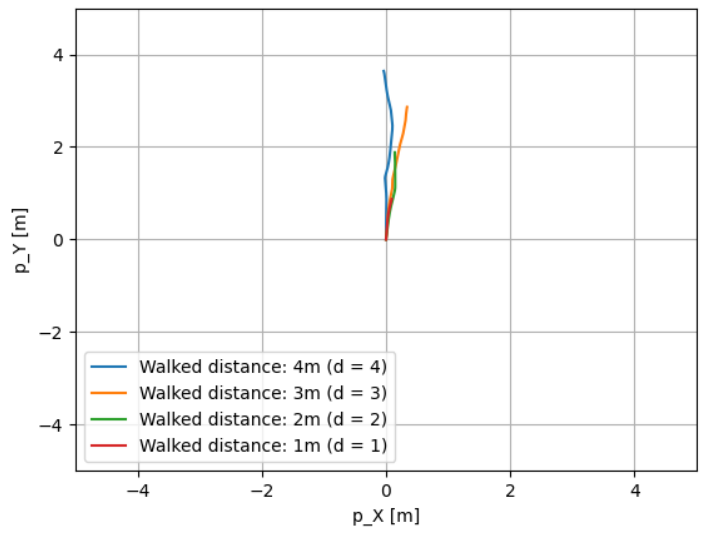
Figure 14. The results of route 1. Table 2. The results of route